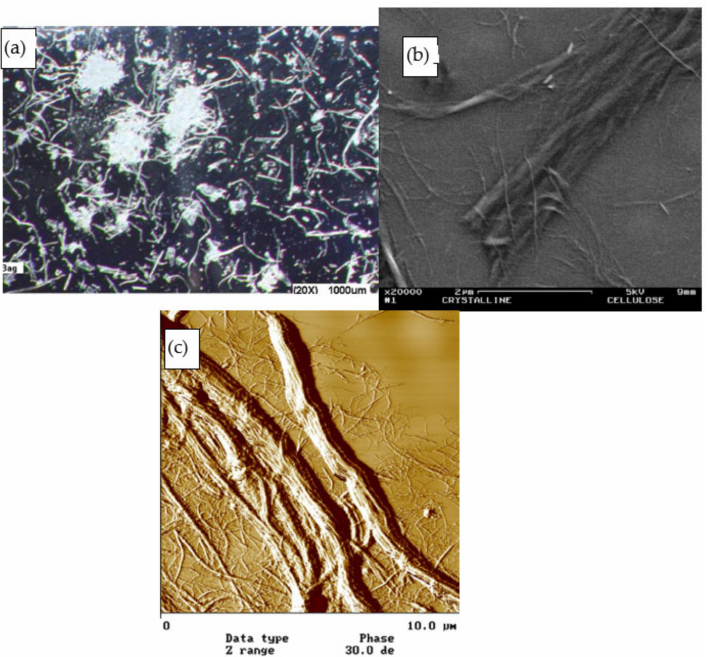
Figure 7. ( a ) Optical, ( b ) scanning electron microscope (SEM), and ( c ) atomic forced microscopy (AFM) micrographics of cellulose microfibers obtained from bagasse. Reproduced with permis- sion [55]. Copyright 2008 Elsevier.